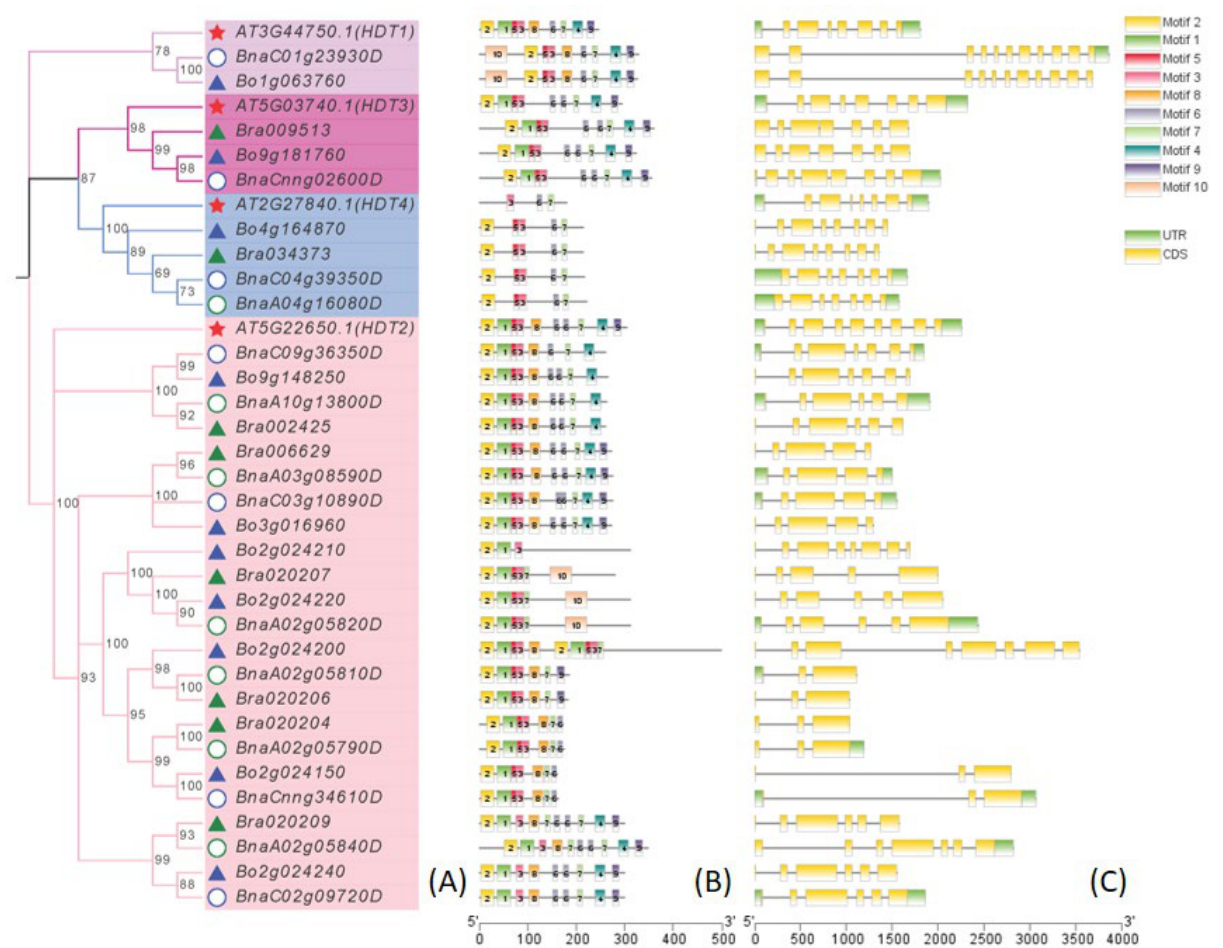
Figure 3. Phylogenetic tree ( A ), gene motifs ( B ) and gene structure ( C ) of HDT of Arabidopsis , B. rapa , B. oleracea and B. napus . Neighbor-joining phylogenetic tree showing the relationship among 8 B. rapa (green triangle), 10 B. oleracea (blue triangle), 14 B. napus (circle) and 4 Arabidopsis HDT proteins ( A ). The resulting four groups are labeled (Group I–IV). Ten motifs in HDT proteins were identified by MEME tools ( B ). Yellow boxes, black lines and green boxes indicate exons, introns and untranslated regions, respectively ( C ).